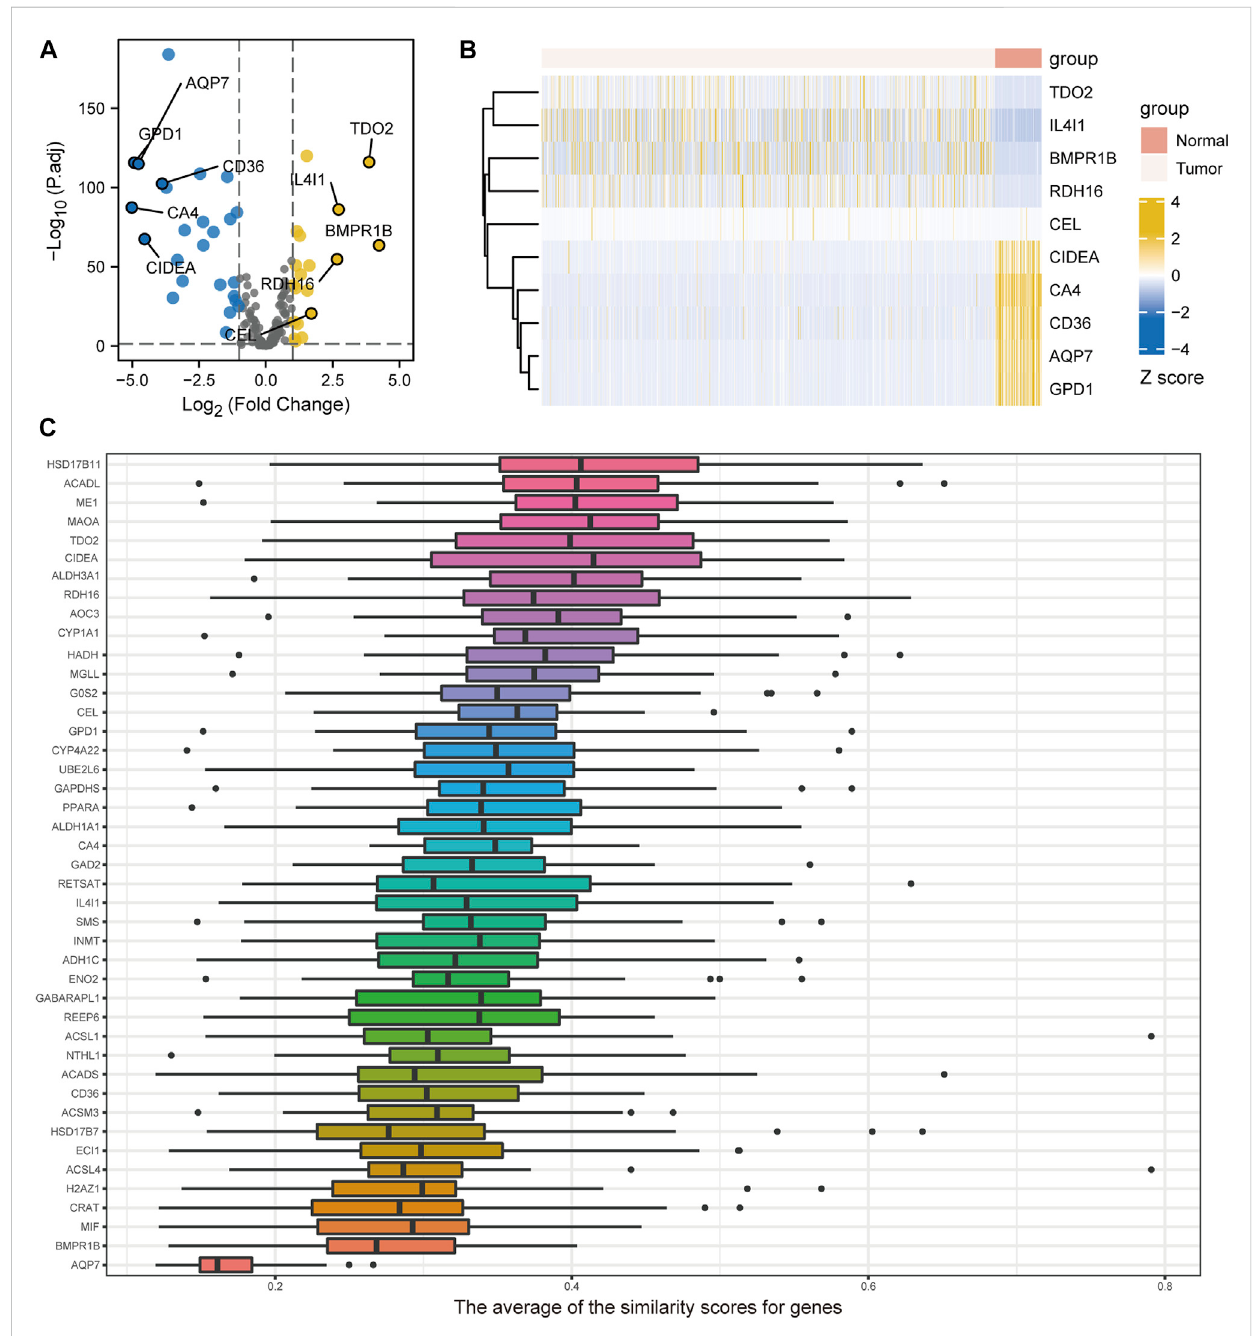
FIGURE 2 Differentially expressed genes (DEGs) related to fatty acid metabolism. (A) Volcano plot of TCGA-BRCA fatty acid metabolism-related genes in breast cancer and control samples. (B) Heatmaps illustrating differential expression of fatty acid metabolism-related genes from breast cancer and control samples from the TCGA-BRCA study. (C) Friends-based analysis demonstrating fatty acid metabolism-related